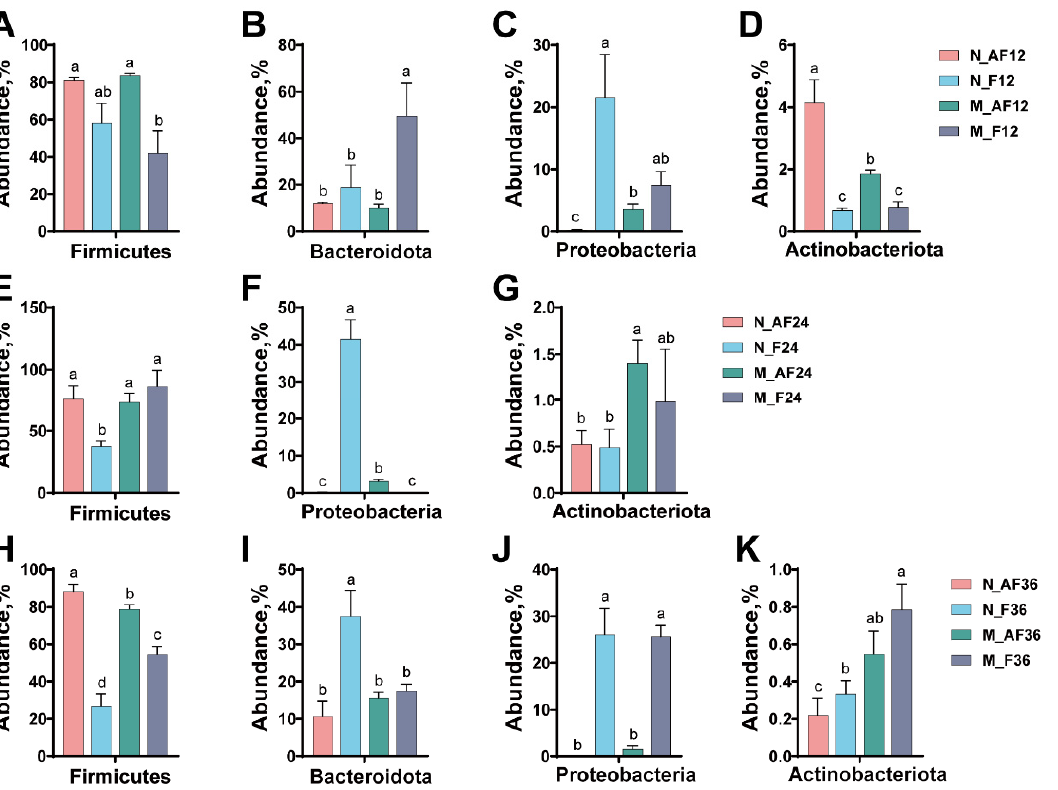
Figure 7. The relative abundance of the predominant bacterial phyla (Firmicutes, Bacteroidetes, Actinobacteria and Proteobacteria) at the time point of 12 h ( A – D ), 24 h ( E – G ) and 36 h ( H – K ) during in vitro fermentation using digesta of Barley. Statistical significance was analyzed by Kruskal–Wallis H test.